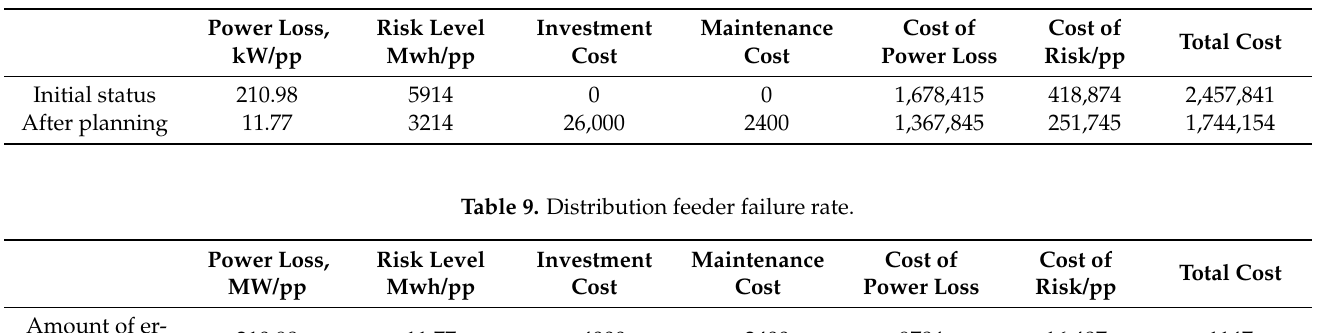
Table 8. Simulation result for base case and Scenario 4.